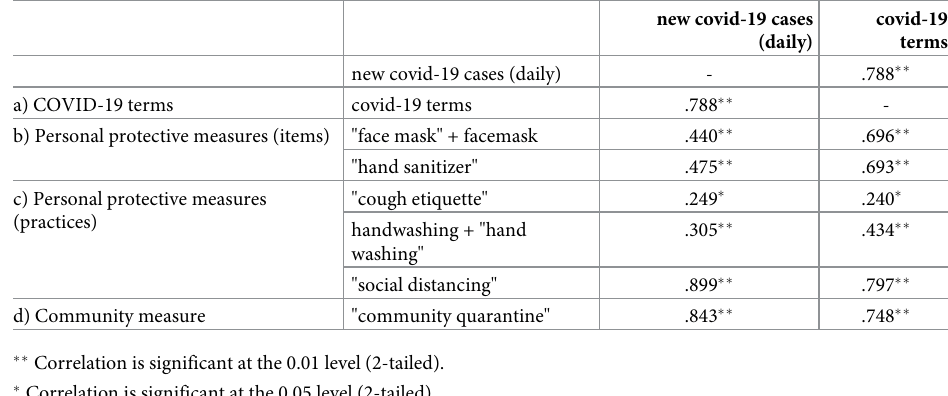
Table 6. Correlation between new daily cases and a) COVID-19 terms; b) Personal protective items; c) Personal protective practices; and d) Community